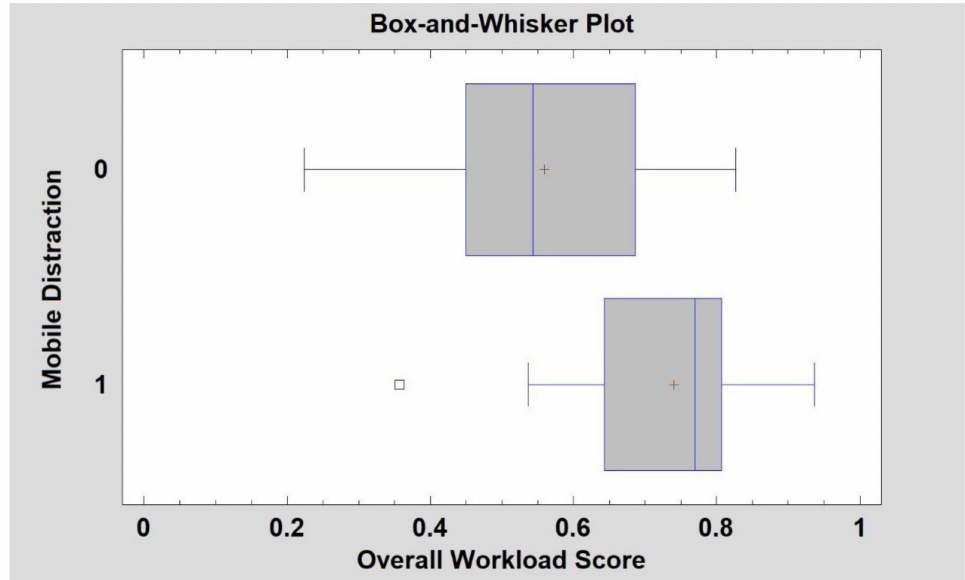
Figure 6. NASA-TLX scores with and without mobile phone